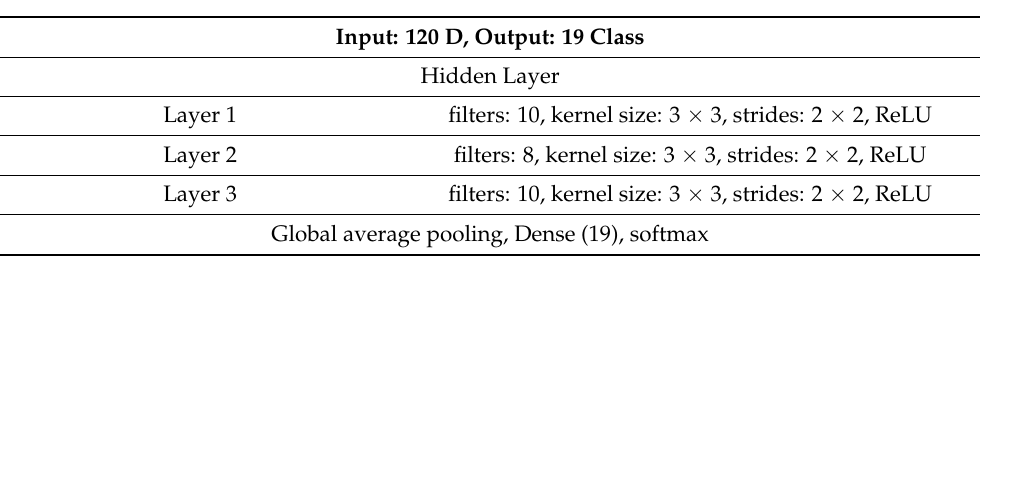
Table A1. Structure of the CNN–PPG-based SCR